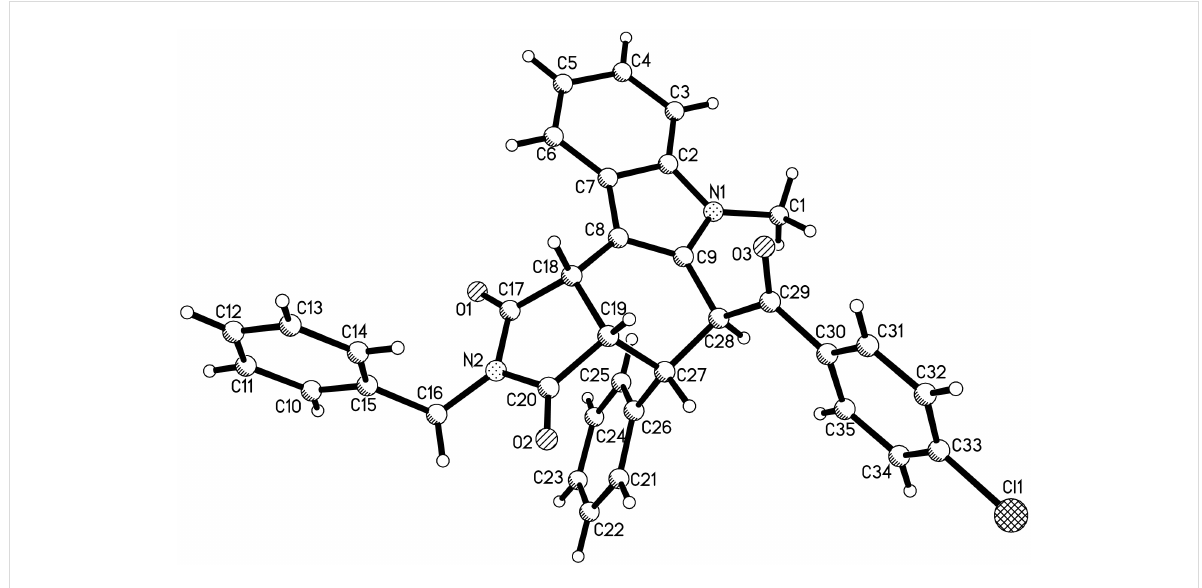
Figure 2: Single crystal structure of the isomer 3a .